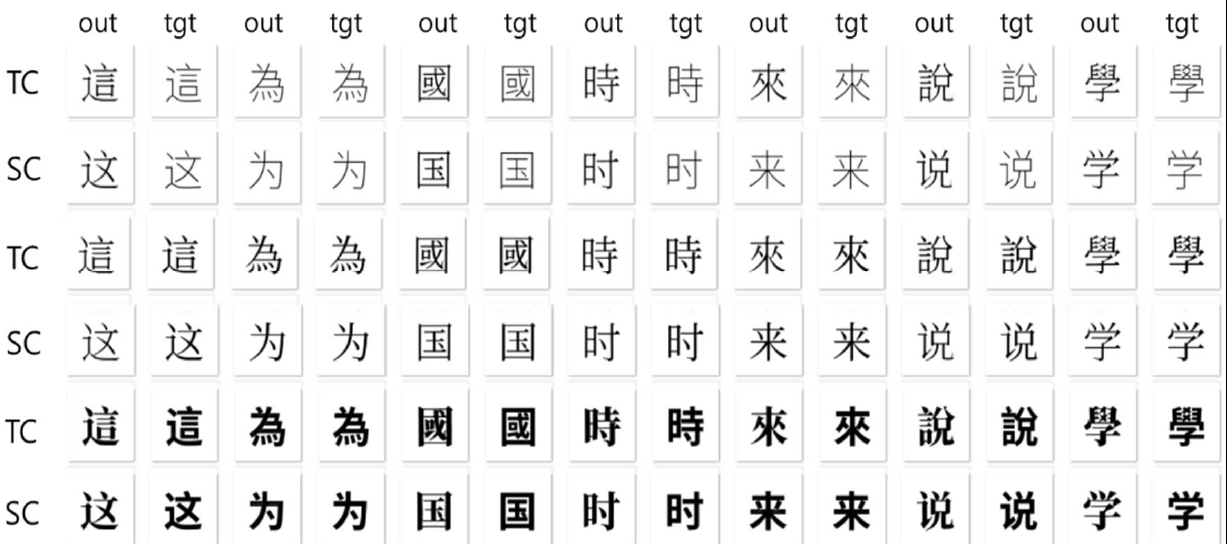
Figure 18. Generated output of TC and SC comparison by the CCFont model.